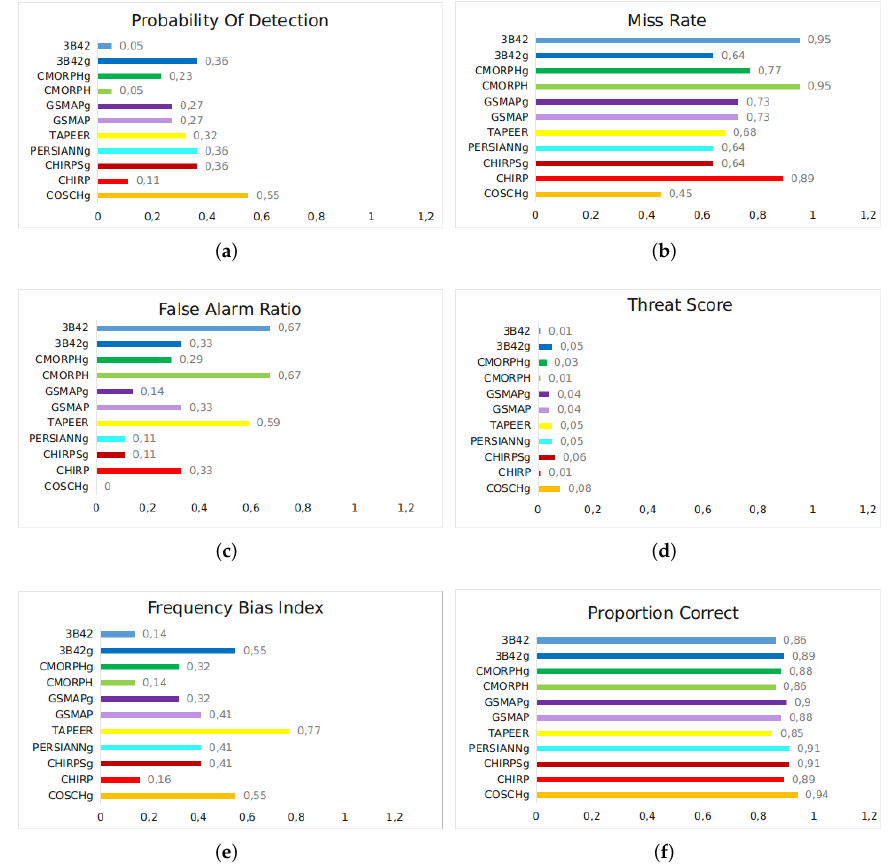
Figure 10. Bar graphs of ( a ) Probability Of Detection (POD); ( b ) Miss Rate (MR); ( c ) False Alarm Ratio (FAR); ( d ) Threat Score (TS); ( e ) Frequency Bias Index (FBI); and ( f ) Proportion Correct (PC) for five days of accumulated precipitation over the central region of Brazil from 1 January 2012 to 5 January